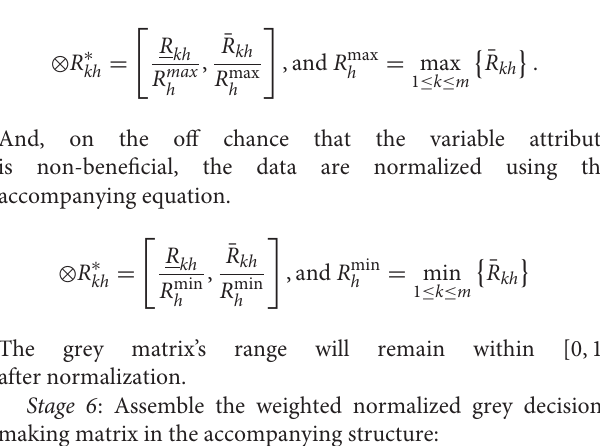
Stage 6 : Assemble the weighted normalized grey